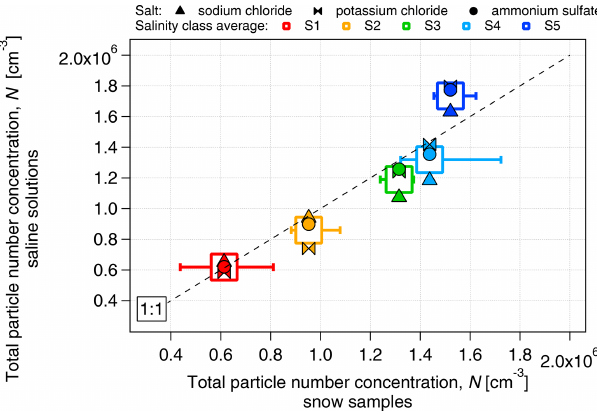
Figure 4. Comparison of the number concentration of aerosolized particles produced from inorganic salt solutions (sodium chloride, potassium chloride and ammonium sulfate) and snow samples as a function of salinity.